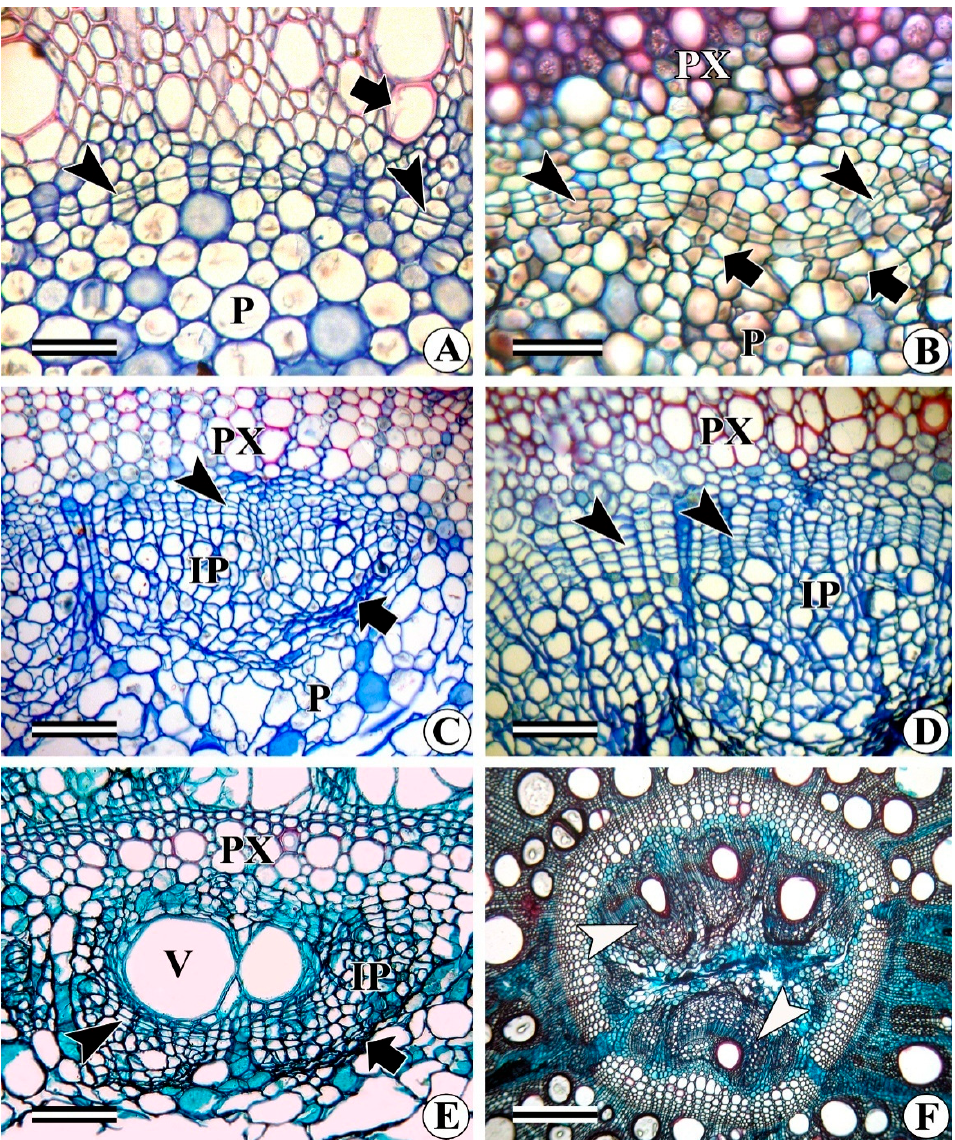
Figure 10. Transverse view of the stems of different species showing the initiation of intraxylary phloem (peri-medullary) cambium. ( A ) Initiation of intraxylary phloem cambium development in Beaumontia jerdomiana . Note the peri-medullary cells showing the initiation of cell division (arrowheads). The arrow shows the protoxylem vessel. ( B ) Intraxylary phloem cambium (arrowheads) and its derivatives in Campsis radicans . Arrows indicate sieve elements. ( C ) Unidirectional activity of intraxylary phloem cambium in Dicranostylis ampla showing only phloem (IP) formation. Arrowhead indicates cambium and the arrow shows crushed intraxylary phloem. ( D ) Intraxylary phloem cambium (arrowheads) showing cells arranged in radial files and phloem (IP) deposited by the cambium in Merremia dissecta . ( E ) Bidirectional activity of intraxylary phloem cambium in Ipomoea hederifolia . Arrowhead indicates intraxylary phloem cambium and the arrow indicates crushed intraxylary phloem. ( F ) Bidirectional activity of intraxylary phloem cambium showing secondary xylem and phloem (arrowheads) deposited in the pith. Abbreviations : P = pith, PX = protoxylem, IP = intraxylary phloem, V = vessel. Scale bars : A = 50 µm, B-E = 100 µm, F = 500 µm.